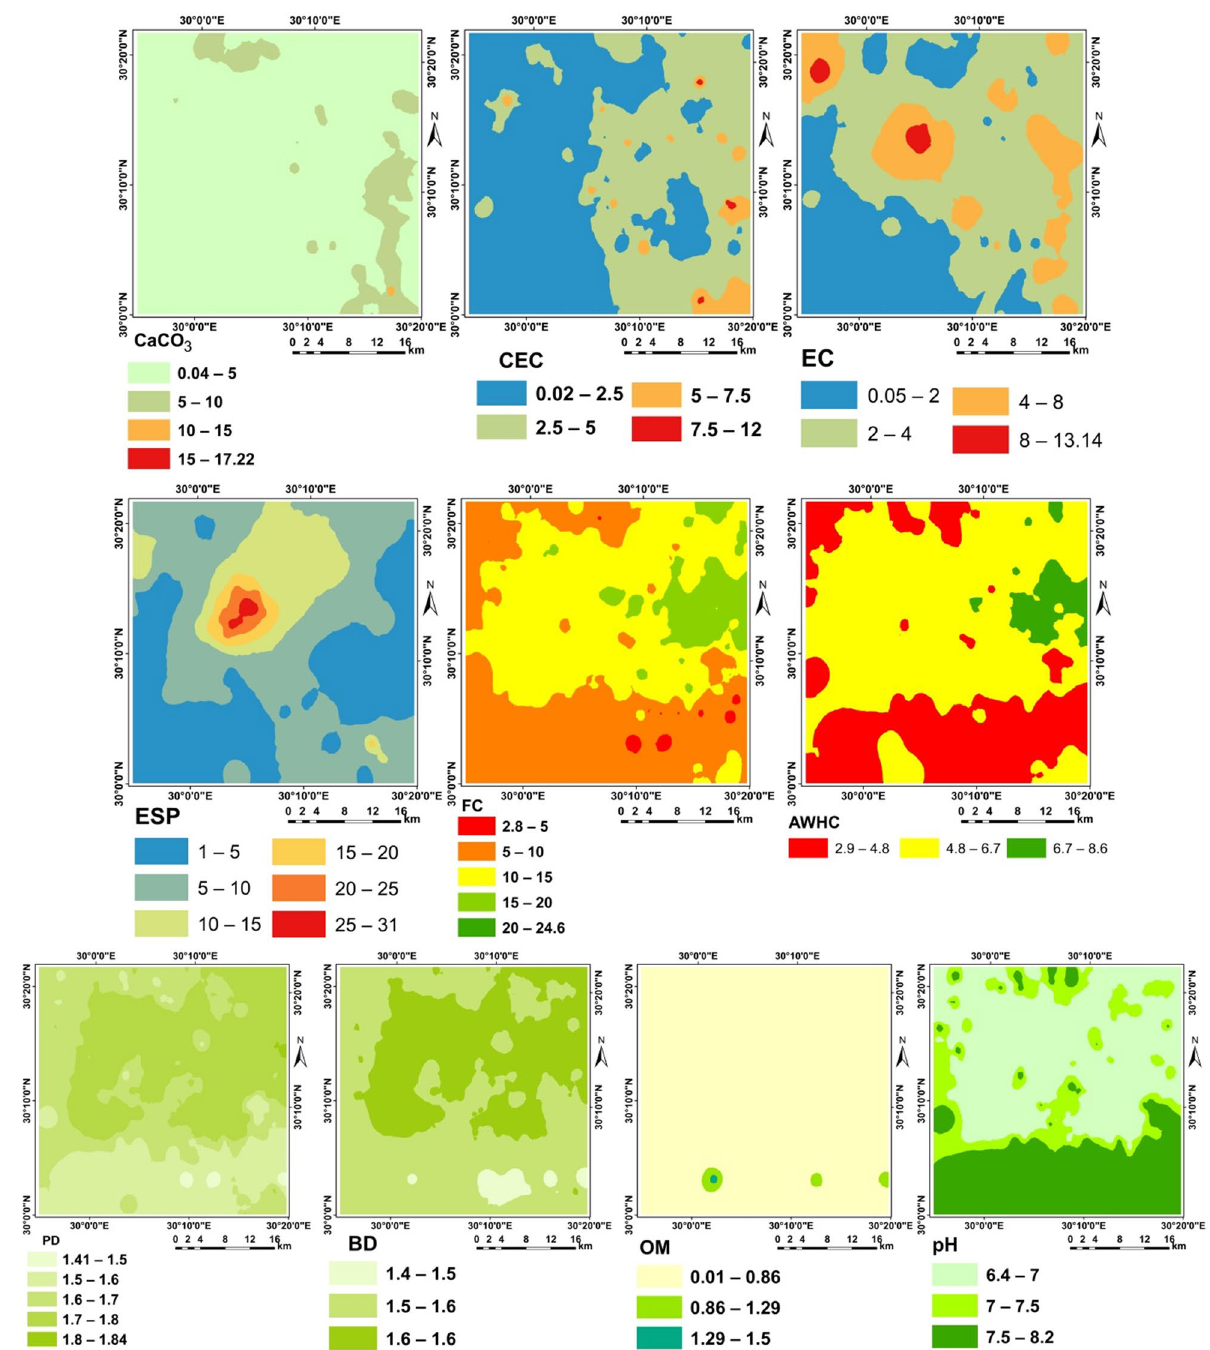
Figure 4. Spatial variation of investigated soil properties.